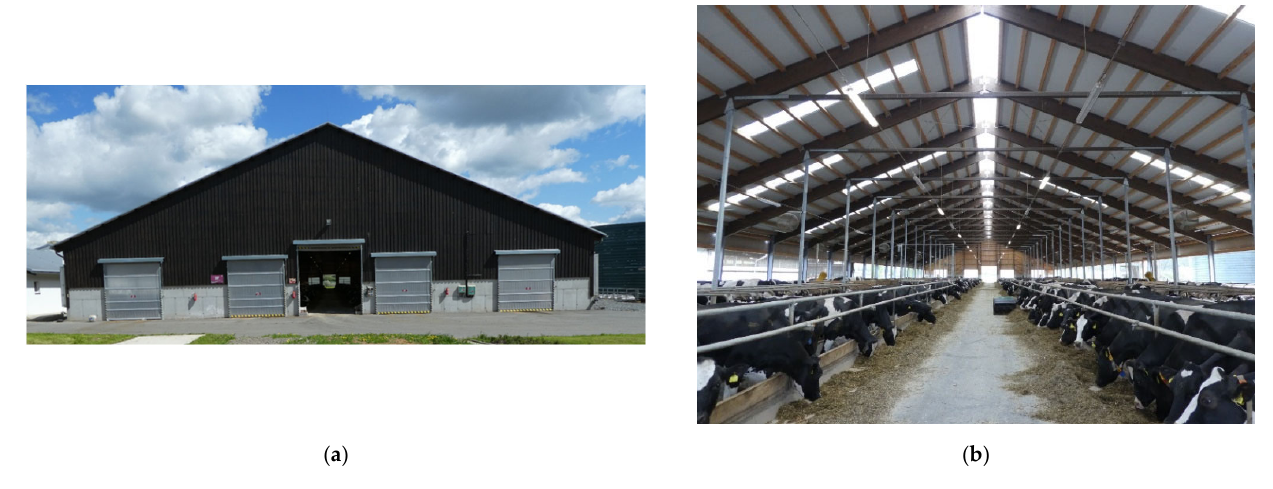
Figure 1. The cowshed for lactating cows (LC): ( a ) the front view of the cowshed; ( b ) the interior of the cowshed.